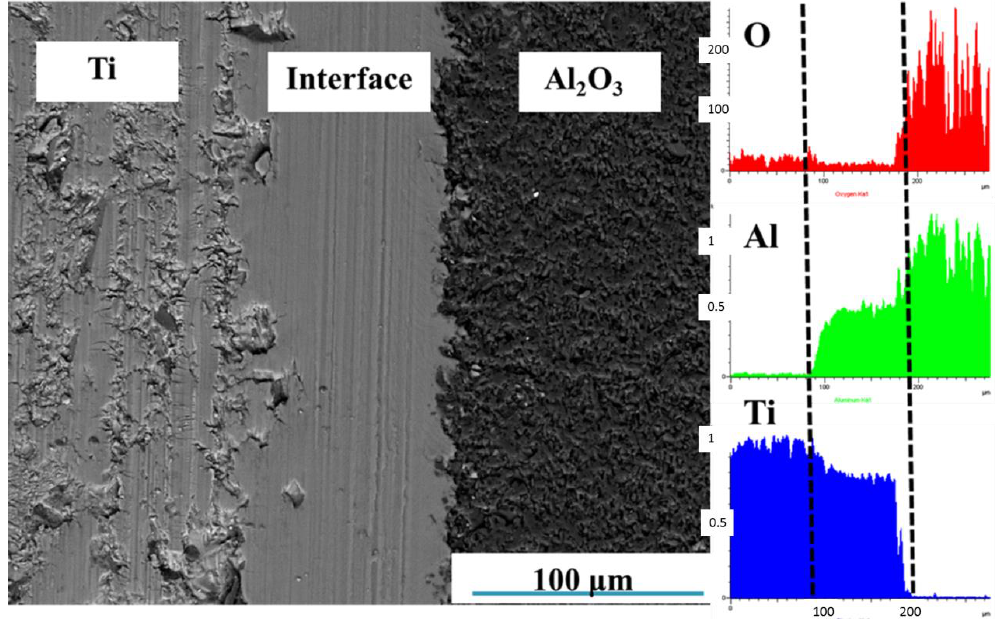
Figure 8. SEM images and line scanning analysis of the interface at 1450 °C with a holding time of 2.5 h.